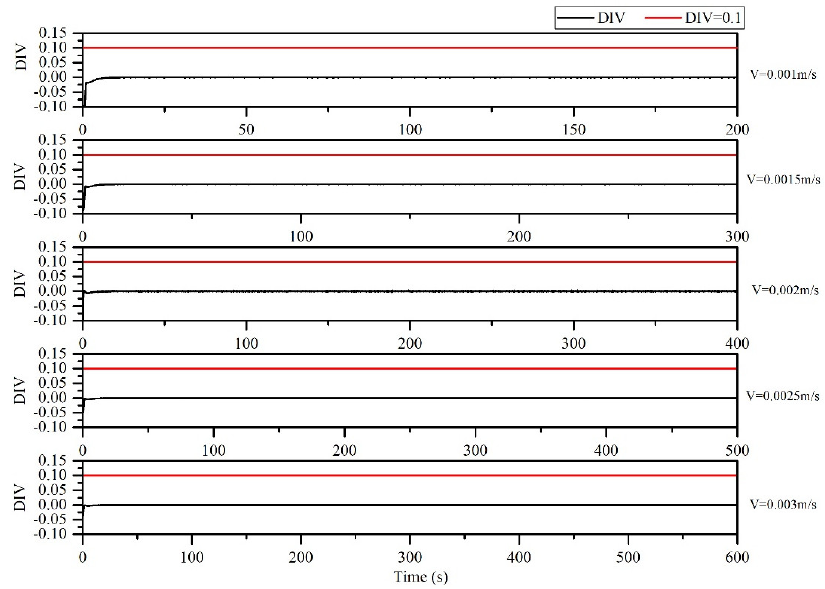
Figure 30. DIV diagram of temperature monitoring in microreactor under different inlet flow rates.